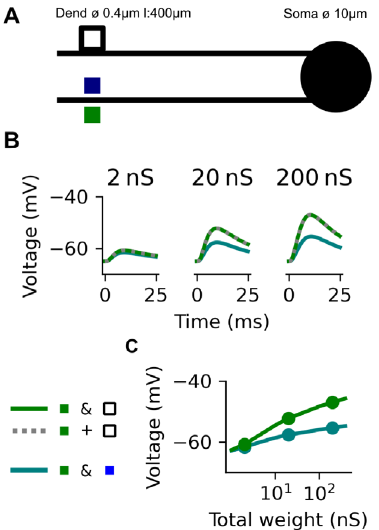
Figure 4. A biophysical model sensitive to synapses’ spatial distribution. A : A biophysical model with two dendrites and a soma (lines: dendrites, circle: soma). Coloured squares depict synapses. The model has three equivalent groups of synapses (black edges/blue/green). B : Somatic membrane voltage traced in 3 scenarios: either two groups of synapses activated simultaneously (& symbol) or we linearly added the response from two synaptic groups (+ symbol) note that the green and dotted grey line overlay C : Maximal membrane voltage at the soma depending on the total synaptic weight for either clustered (aquamarine) or dispersed (green) stimulation. We omitted the grey dotted line here as it overlays with the